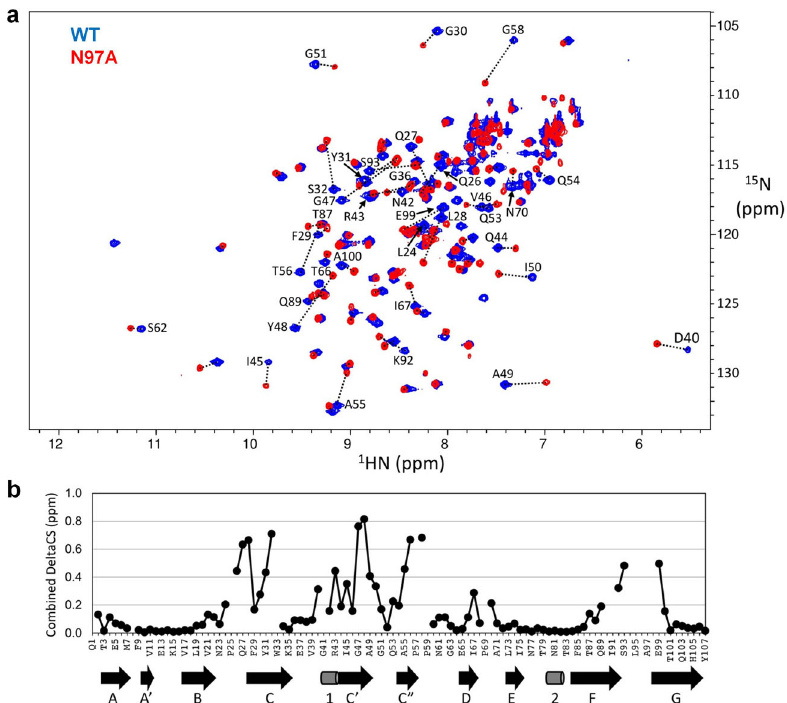
Fig. 6 15 N-HSQC spectra of WT and N97A mutant hCEACAM1 IgV protein. a Overlaid 15 N-HSQC spectra of WT (blue) and N97A mutant (red) hCEACAM1 IgV protein. The corresponding assigned residues with major peak shifts were indicated and connected by dotted lines. b Combined 1 HN and 15 N chemical shift changes, sqrt( δ csH 2 + ( δ csN/5) 2 ), between WT and N97A mutant hCEACAM1 IgV are shown in comparison with the secondary structure elements from the X-ray structure of WT hCEACAM1 depicted